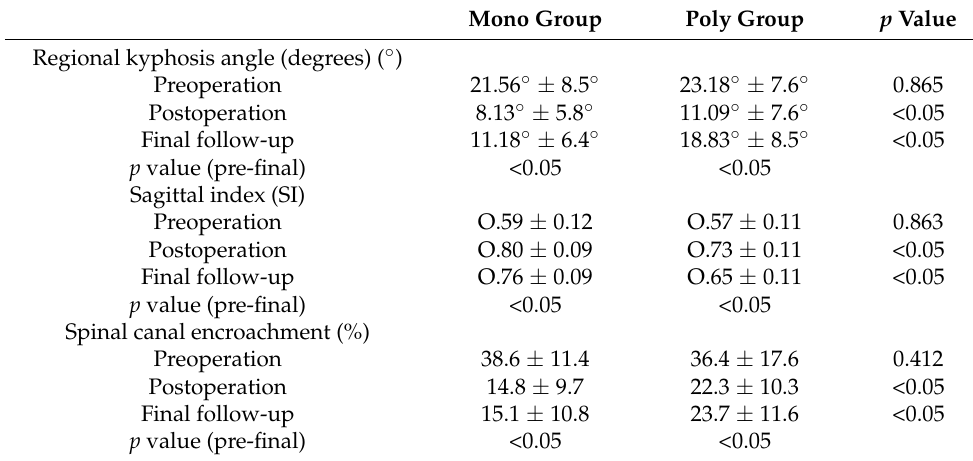
Table 2. Comparisons of radiographic data between the two groups.